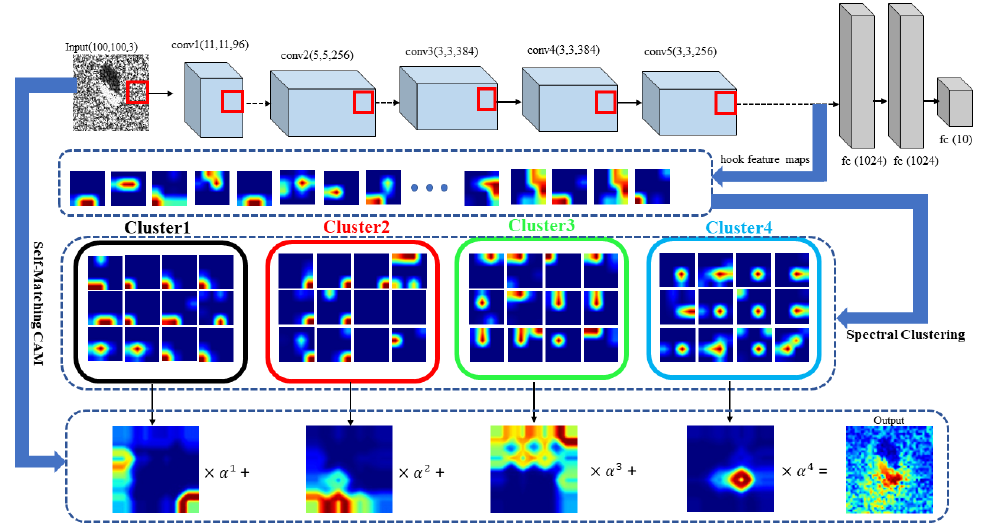
Figure 1. Flowchart of SC-SM CAM. Here, the AlexNet model is taken as an example. Algorithm 1: SC-SM